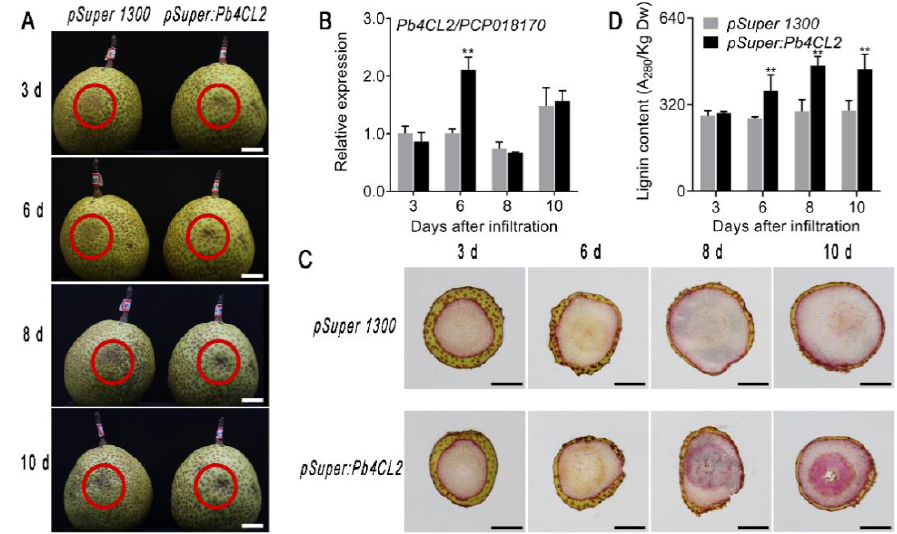
Figure 4. Transient expression of Pb4CL2 in ‘Chili’ pear fruit. ( A ) Fruit phenotype of fruit at 3, 6, 8, and 10 d after injection of pSuper:Pb4CL2 or empty vector. Scale bar = 2 cm. ( B ) The expression of Pb4CL2 in pear fruit surrounding the injection site. ( C ) Wiesner staining of fruit sections at 3, 6, 8, and10 d after infiltration of pSuper:Pb4CL2 or empty vector. Scale bar = 2 cm. The lignin content ( D )